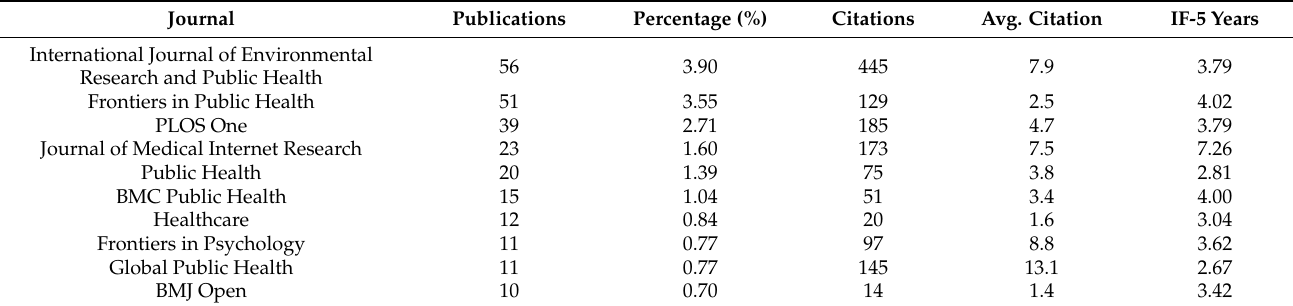
Table 2. Top 10 most productive